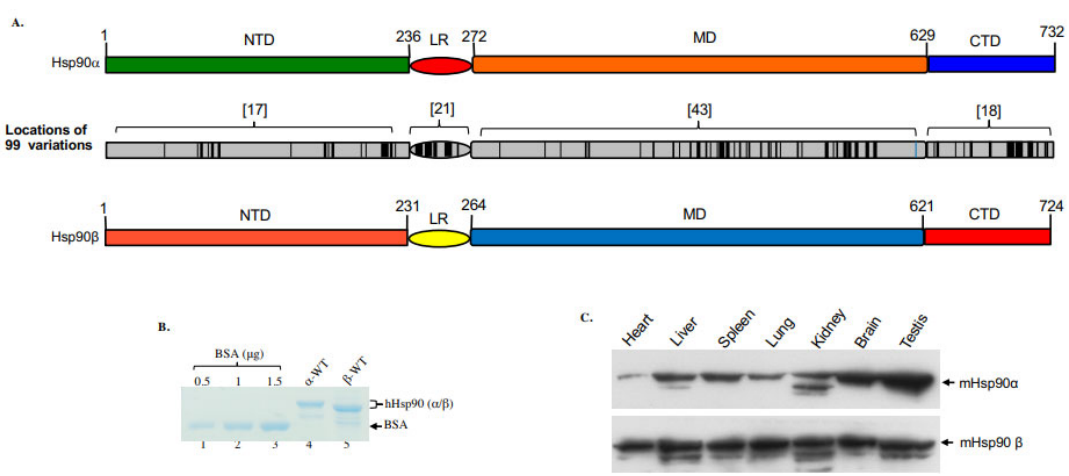
Figure 1. Variations in location, molecular mass and expression in mouse organs between Hsp90 α and Hsp90 β . ( A ) Locations (black colored) of the 99 amino acid substitutions and deletions between human Hsp90 α and Hsp90 β , in which the LR shows the highest percentage of the mutations. ( B ) The molecular mass of human recombinant Hsp90 α and Hsp90 β on an SDS-PAGE gel. ( C ) The relative expression of Hsp90 α and Hsp90 β in indicated mouse organs in reference to equalized total proteins of the various